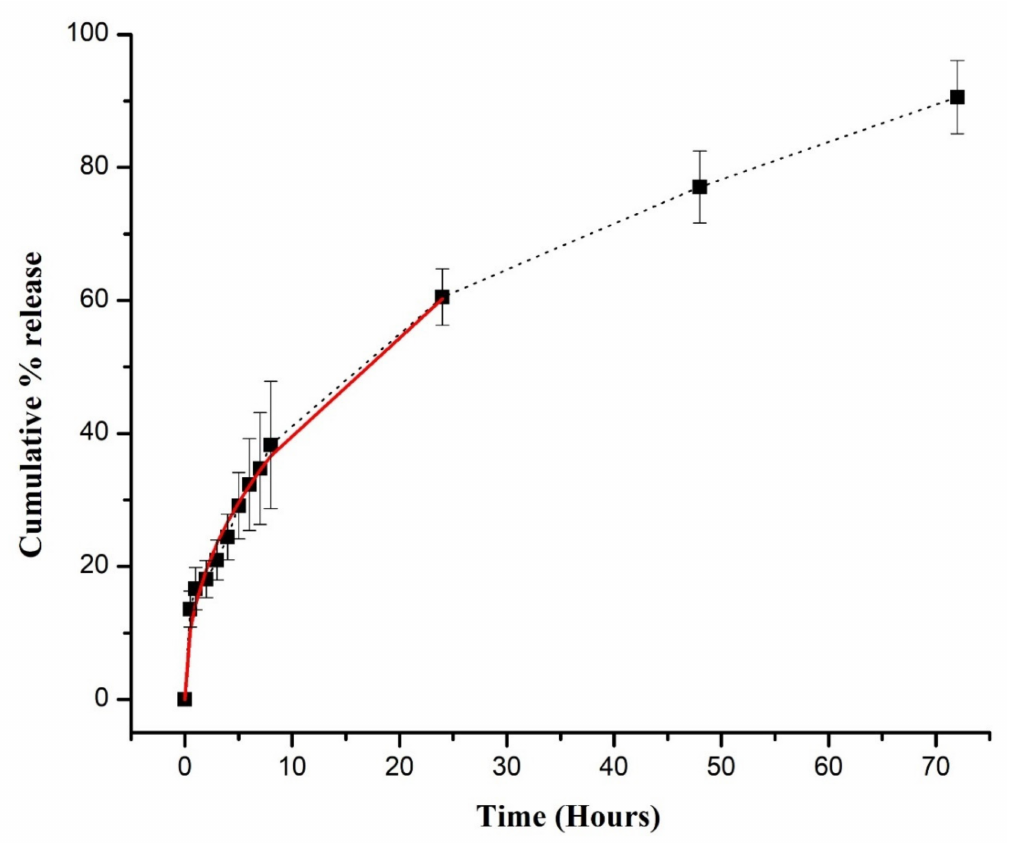
Figure 11. In vitro DSP release from semi-IPN hydrogels (AG-1) (shown by black dotted line). Release curve shows Korsmeyer–Peppas model on the first 60% release (shown by red continuous line). Error bars represents means ± SD ( n =